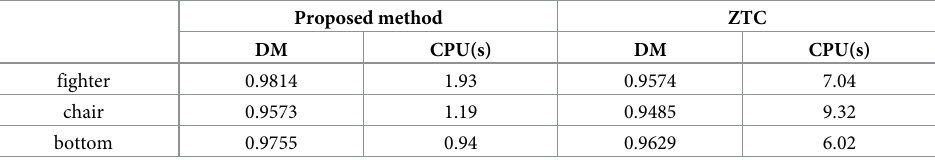
Table 4. The number of iterations to reach convergence (iters) and the total CPU time in seconds (CPU(s)) for dif- ferent images of different sizes by using our algorithm and the ZTC algorithm in the segmentation problem. Proposed